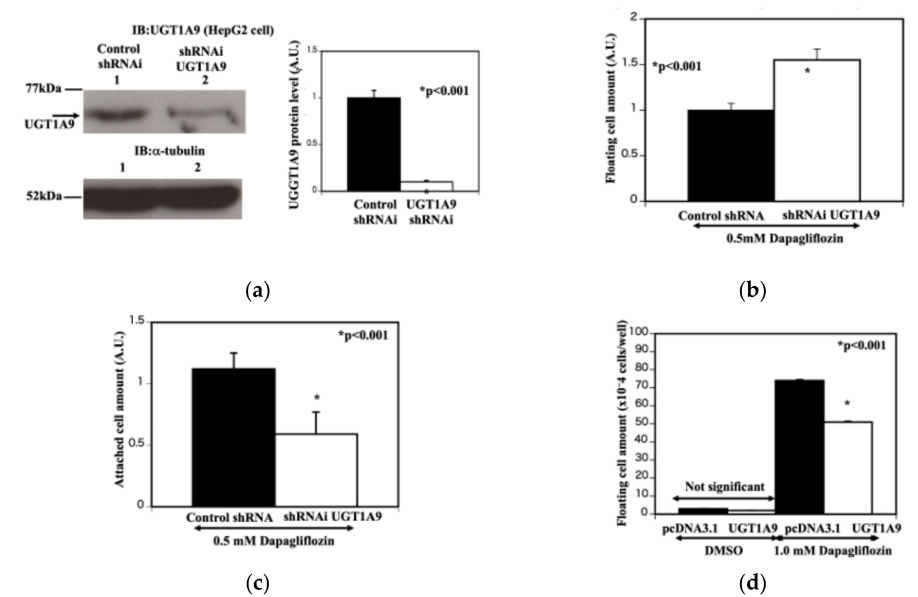
Figure 3. UGT1A9 protein level is critical for susceptibility of dapagliflozin in HepG2 and HCT116 cells. ( a ) Knockdown of UGT1A9. HepG2 cells were transfected with either control shRNAi (lane 1) or UTG1A9-specific shRNA (lane 2). Cell extracts were prepared and immunoblotted for UTG1A9 (upper panel) and alpha-tubulin (lower panel). The quantification of the relative amounts of UTG1A9 protein levels compared with alpha-tubulin is shown as a bar graph (n = 3, control shRNAi vs. UGT1A9-specific shRNA, * p < 0.001). The Y -axis represents the UGT1A9 protein level. The closed column represents control shRNAi-treated HepG2 cells and the open column represents UTG1A9 specific shRNA-treated HepG2 cells. ( b ) Estimation of floating cell amount (HepG2 cells). The control shRNAi-treated and UTG1A9-specific shRNA-treated HepG2 cells were treated with 0.5 mM dapagliflozin for 35